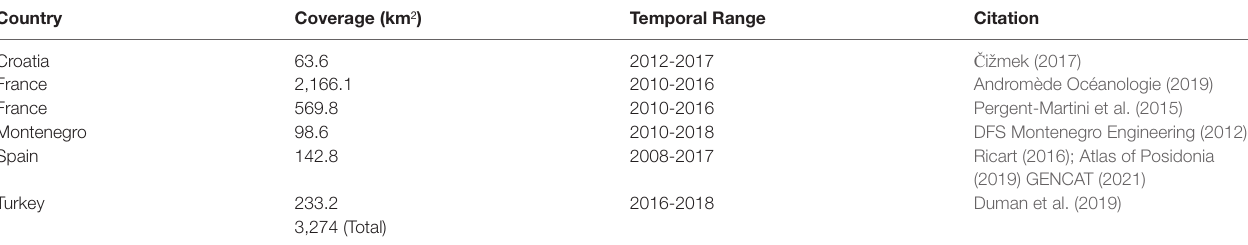
TABLE 2 | Analytical information about the herein employed independent validation (reference) data. Country